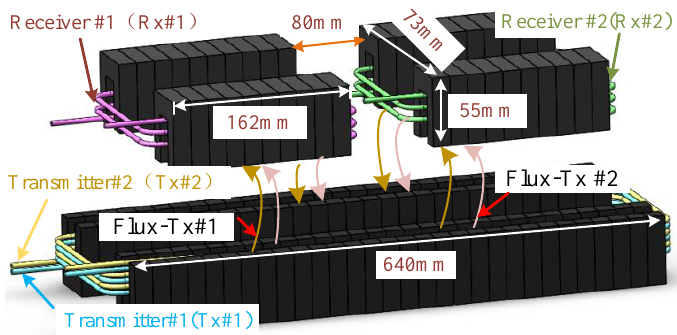
Figure 1. The structure of the proposed WPT system.